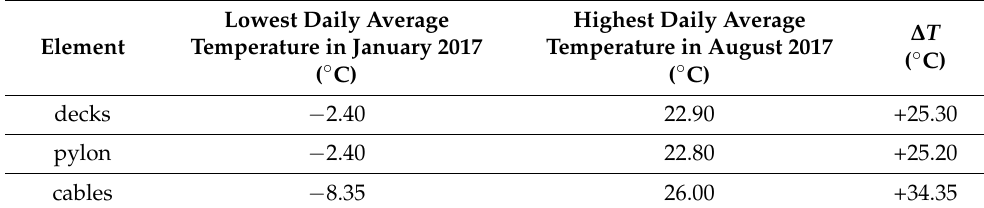
Table 5. Measured temperature differences in structure